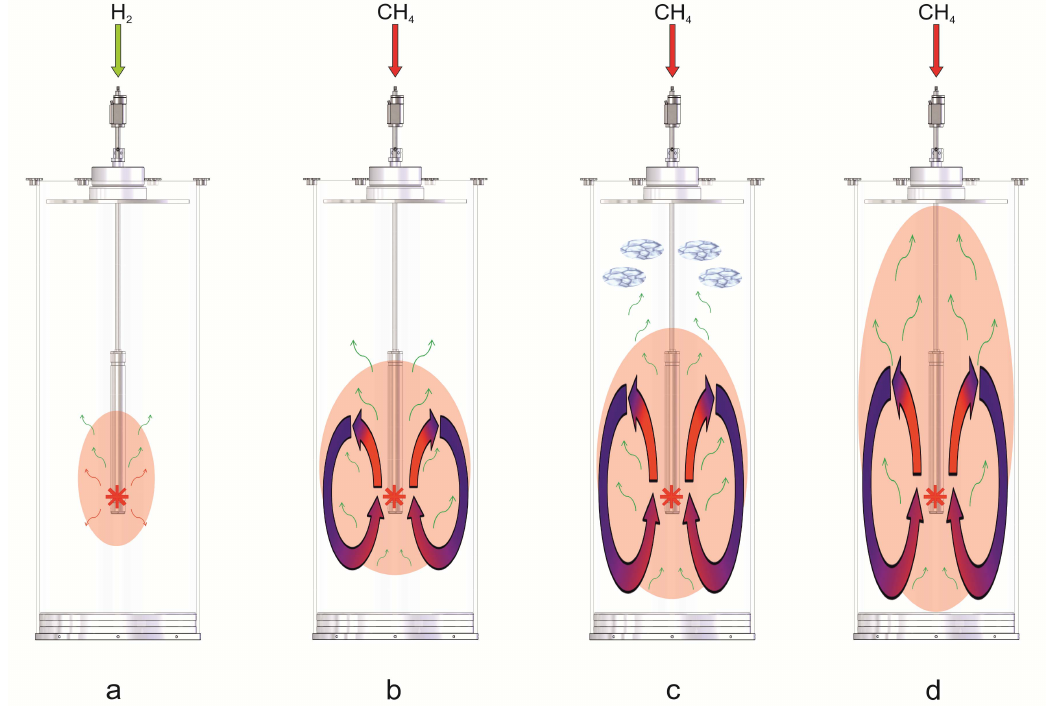
Figure 8. ( a ) During the ignition of the catalyst using H induces hydrate dissociation in the vicinity of the reactor; ( b ) When the fuel is changed to CH the temperature at the catalyst increases rapidly to 450 °C. The generated heat induces 4 a strong increase of the fluid temperature close to the reactor causing a convection process; ( c ) Since the released gas from dissociated hydrates migrates faster through the sediment than the heat front, secondary hydrates form in the colder areas at the top of LARS; ( d ) After 12 h the temperatures in almost all areas of LARS were outside the stability field of hydrate at given CH 4